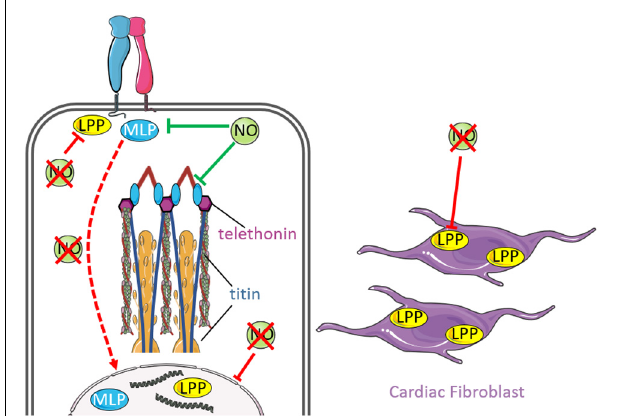
FIGURE 3 | Nitric oxide signaling and mechanical stimuli affects signaling by MLP and LPP. Muscle LIM protein (MLP) is a nucleocytoplasmic protein that interacts with integrins at costameres and forms a mechano-sensing complex with titin and telethonin at the sarcomeric Z-disc (inset). Interestingly, enhanced NO downregulates MLP expression, which is associated with disruption of the MLP-titin-telethonin complex and misalignment of the Z-disc. Loss of NO promotes re-localization of MLP from the cytosol to the nucleus (red dashed arrow), where nuclear MLP has been demonstrated to promote hypertrophy in response to mechanical stress. Lipoma preferred partner (LPP) is another nucleo-cytoplsmic protein that is localized at focal adhesions, cell-cell junctions and communicates between the nucleus and cytoskeleton. The protein is highly expressed in cardiac fibroblasts and participates in cellular adaptations in response to mechanically induced cardiac hypertrophy. Nitric oxide has been proposed to regulates LPP expression following mechanical stress. Loss of NO is associated with reduced expression of nuclear and cytoskeletal LPP